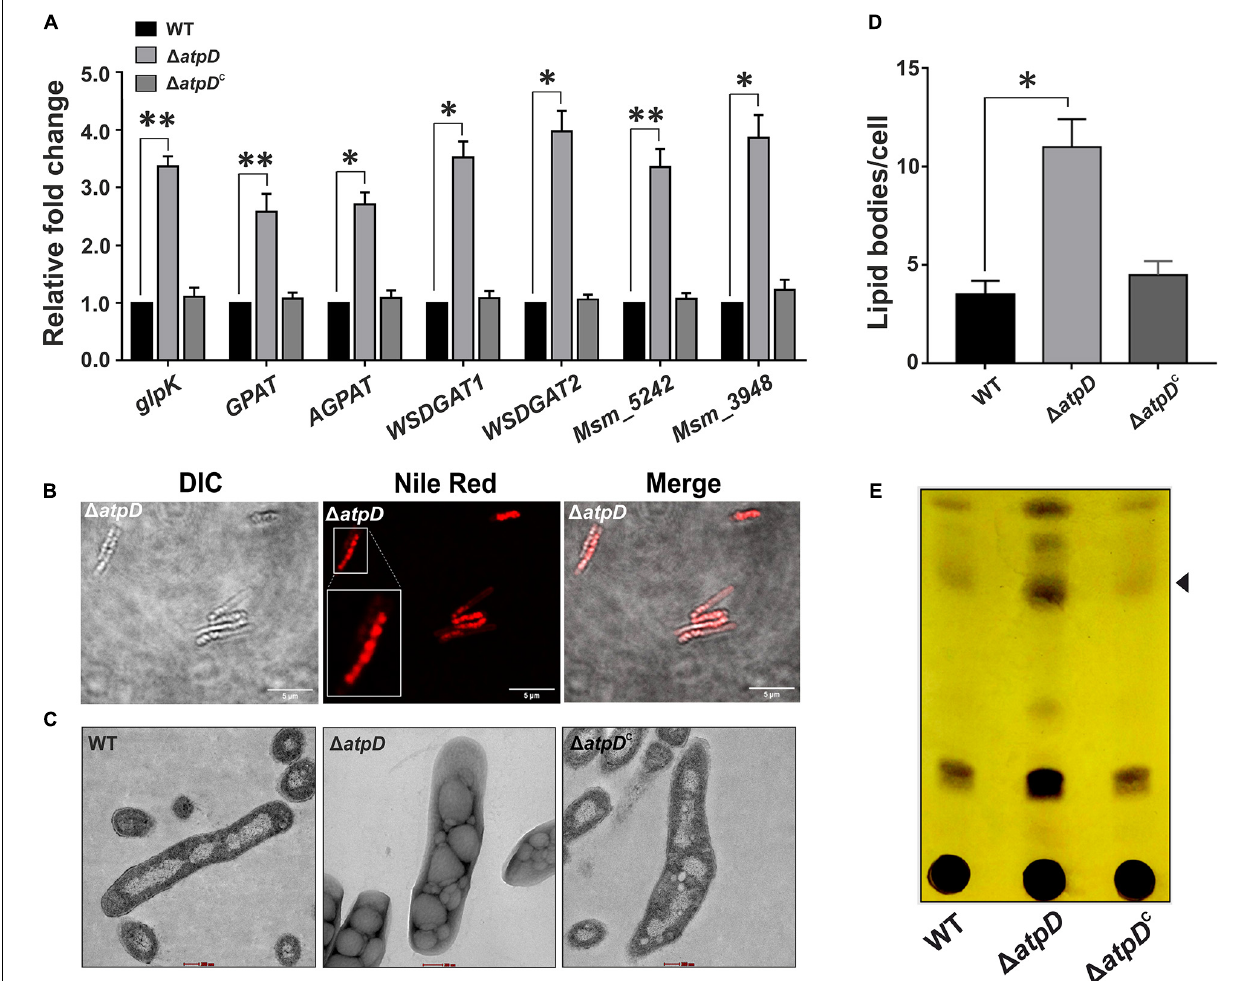
FIGURE 5 | Increased TAG accumulation in M. smegmatis under energy-compromised state. Panel (A) shows the relative mRNA transcript levels of genes belonging to Kennedy pathway such as glycerol kinase ( glpK) , glycerol-3 phosphate acyl transferase ( GPAT ), acylglycerol phosphate acyltransferase ( AGPAT ), two wax ester synthase/acyl-CoA: diacylglycerol acyltransferase ( WSDGAT ) and the TAG synthase genes ( MSMEG_3948 and MSMEG_5242 ; these are homologues of tgs1 in M. tuberculosis ) in M. smegmatis wild-type (WT), atpD knock-out ( (cid:49) atpD ), and atpD -complemented ( (cid:49) atpD C ) strains. The transcript level in each case is compared with that of M. smegmatis WT, which is taken as 1. Panel (B) shows the confocal microscopy images after staining the cells with the Nile red dye. A single zoomed-in image in the Nile red panel is presented as inset for clarity. Panel (C) shows the transmission electron microscopy (TEM)-based ultrastructural analysis of all the three strains for the presence of lipid bodies (LBs). The scale bar in each image corresponds to 200 nm. Panel (D) shows the quantification of the LBs ( n = 23) for the images obtained in panel (C) . Panel (E) depicts the TLC image presenting the TAG accumulation in M. smegmatis WT, atpD knock out ( (cid:49) atpD ), and (cid:49) atpD C strains. Spot corresponding to the TAG is marked with an arrowhead. In panels (A,D) , data show an average of at least three independent experiments with error bars representing standard deviation. ∗ P -value < 0.05; ∗∗ P -value < 0.01. In panels (B,C,E) , only one representative image is